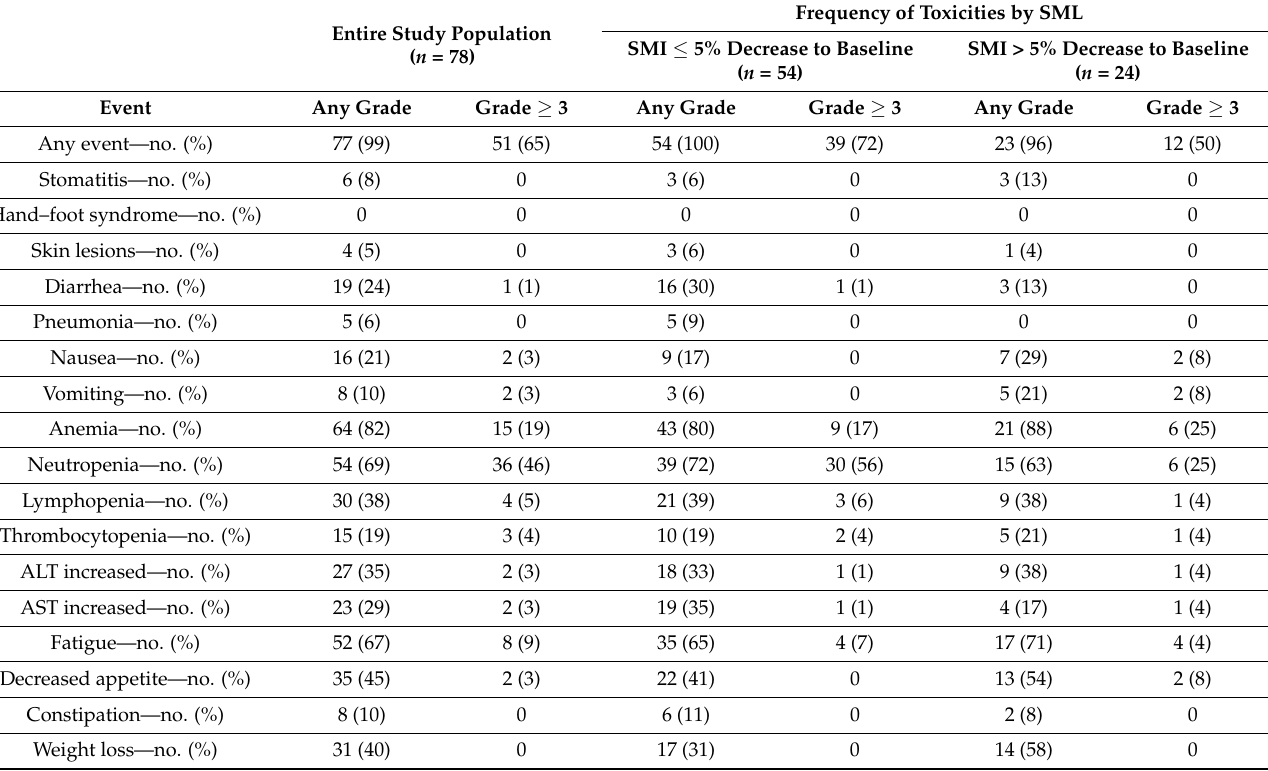
Table 7. Frequency of Adverse